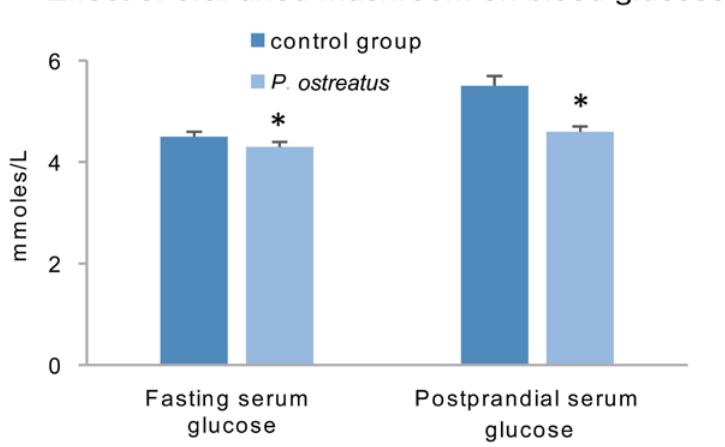
Figure 9. Orally administered dried and powdered Oyster mushrooms (50 mg/kg BW/day) for 2 weeks improved glucose control in type-2 diabetic humans. Adapted from Jayasuriya, et al. [167].